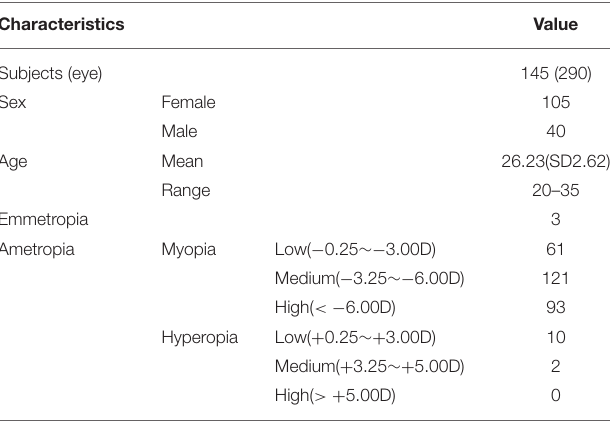
TABLE 1 | Baseline characteristics of the